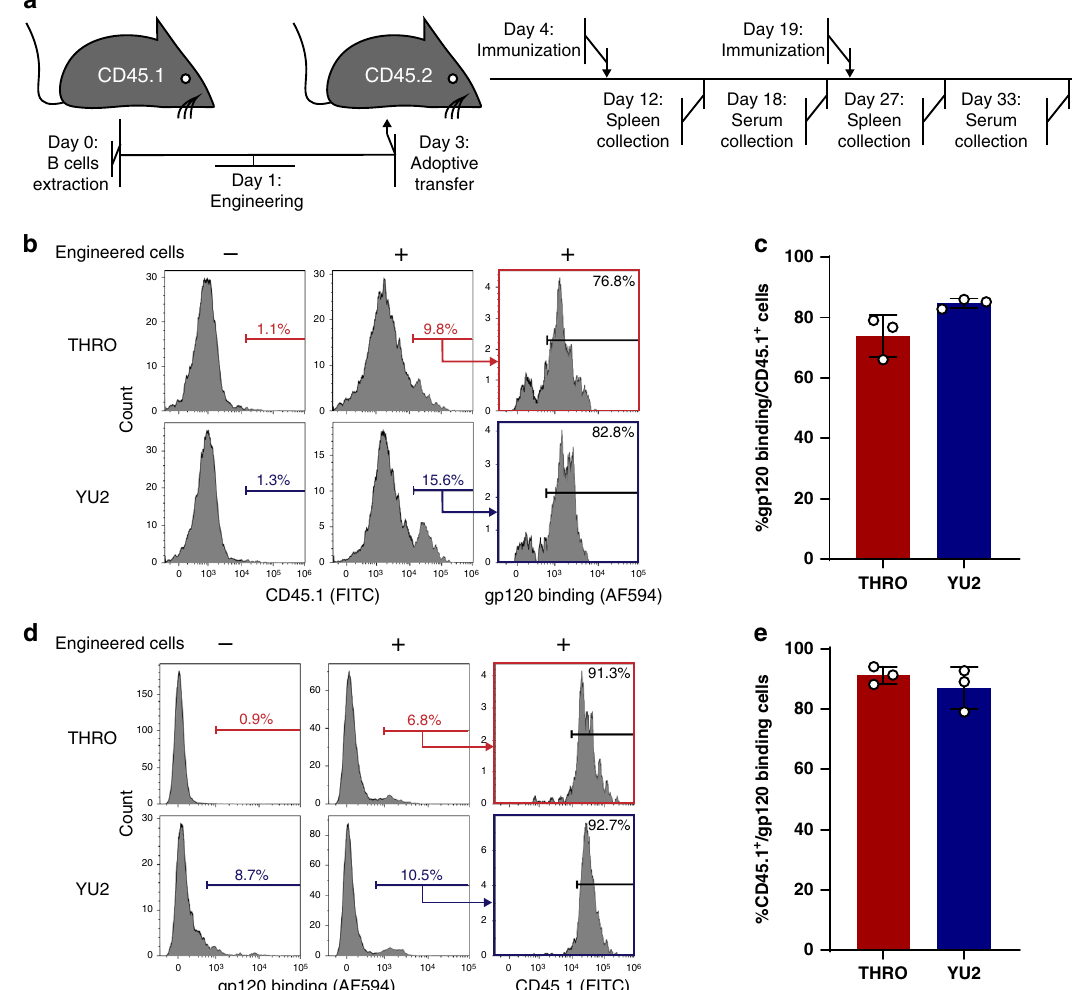
Fig. 3 Adoptively transferred engineered B cells can undergo antigen-induced activation in-vivo. a Experimental scheme of the in vivo assays. Splenic B cells, from C57BL/6 CD45.1 mice, were engineered as in Fig. 1 and infused to otherwise syngeneic CD45.2 recipient mice. Different mice groups were immunized on the following day with gp120 antigens from either the THRO4156.18 (THRO) or the YU2.DG (YU2) HIV strains. When boosted by an additional injection, the mice received the same antigen as in the prime injection. Different mice groups were sacri fi ced 8 days following injections for spleen collection or terminally bled 14 days after injection for serum collection. b Representative analysis by fl ow cytometry of the accumulation of engineered cells in the GCs of mice immunized with either the YU2.DG or the THRO4156.18 gp120 antigens, 8 days following a prime antigen injection. Gating on live, singlets, B220 + , GL-7 + . c Quanti fi cation of b . Each dot represents a different mouse. Error bars represent SD ( n = 3, represents amouse, data represented as mean values + / − SD). d Representative analysis by fl ow cytometry of CD45.1 expression among gp120 binding GC cells. Pre-gating on singlets, live, B220 + , GL-7 + . e Quanti fi cation of d . Each dot represents a different mouse. Error bars represent SD ( n = 3, each dot represents a mouse, data represented as mean values + / − SD). For gating strategy see Supplementary Fig.